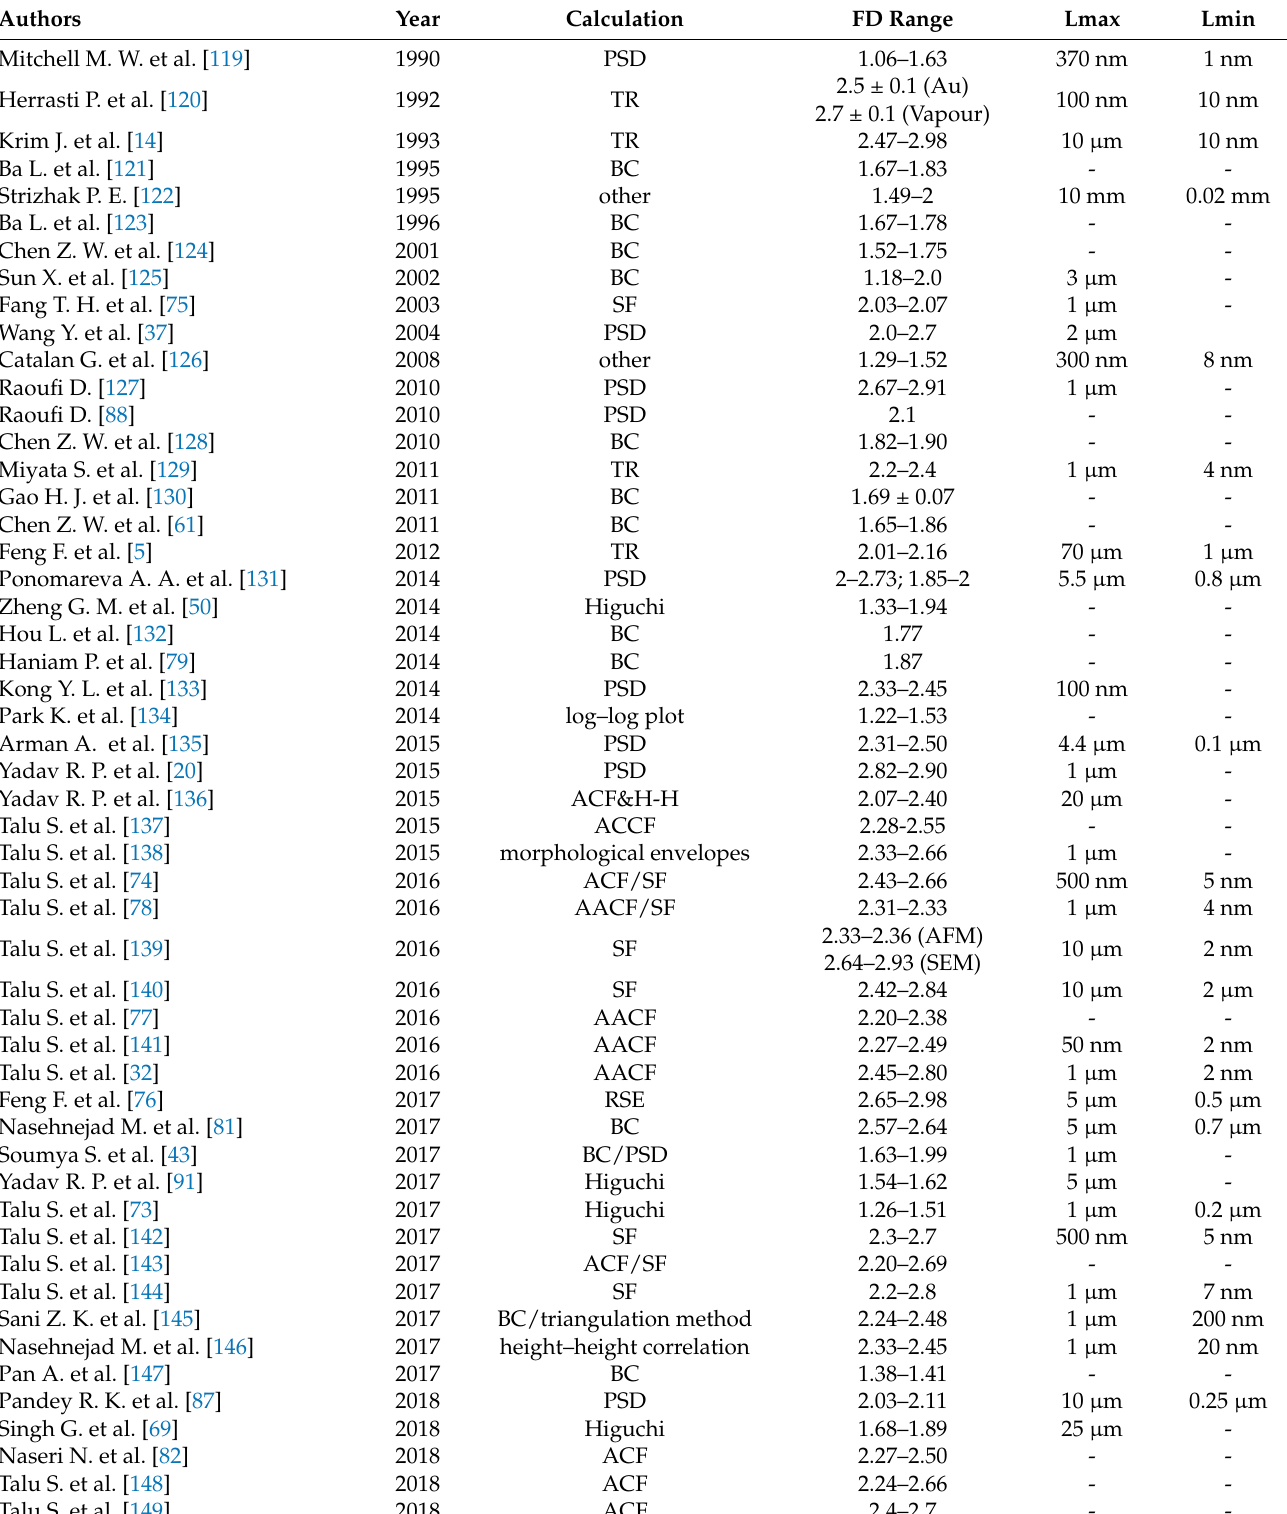
Table A1. Calculation methods and ranges of FD, and the max/min values of scales in fractal literature of thin films